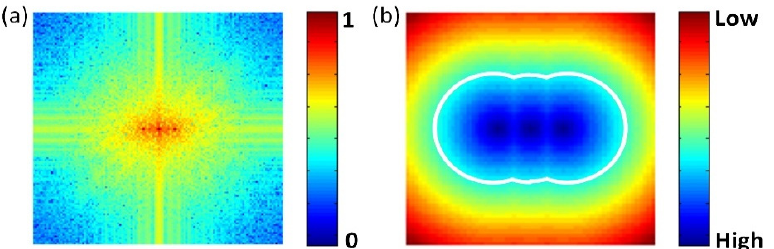
Figure 2. Sampling strategy for single-pixel SFDI. ( a ) Normalized Fourier spectrum of a reflected image, ( b ) modified circular path (white curves) and measuring priority of sampling patterns.